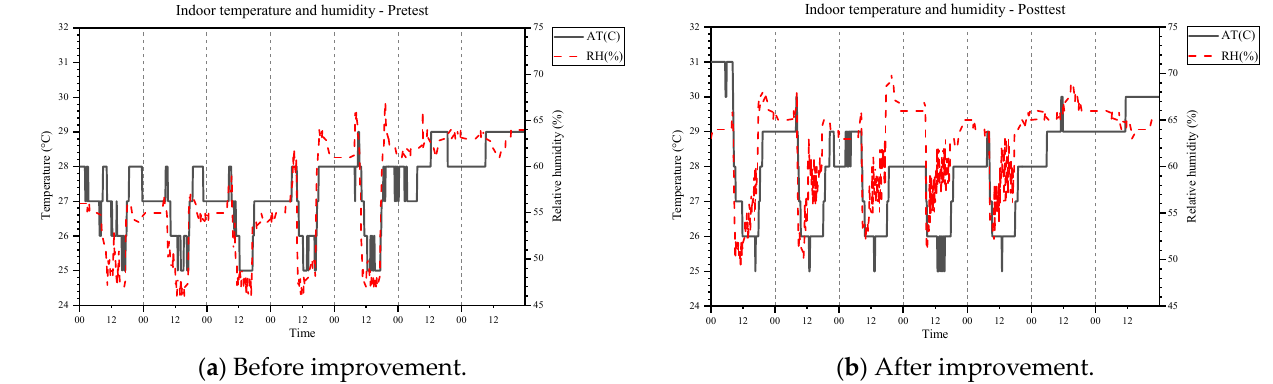
Figure 5. Analysis of the indoor temperature and humidity in the office space before and after the implementation of the improvement plan. Table 2. Comparison of environmental performance indicators before and after the implementation of the improvement